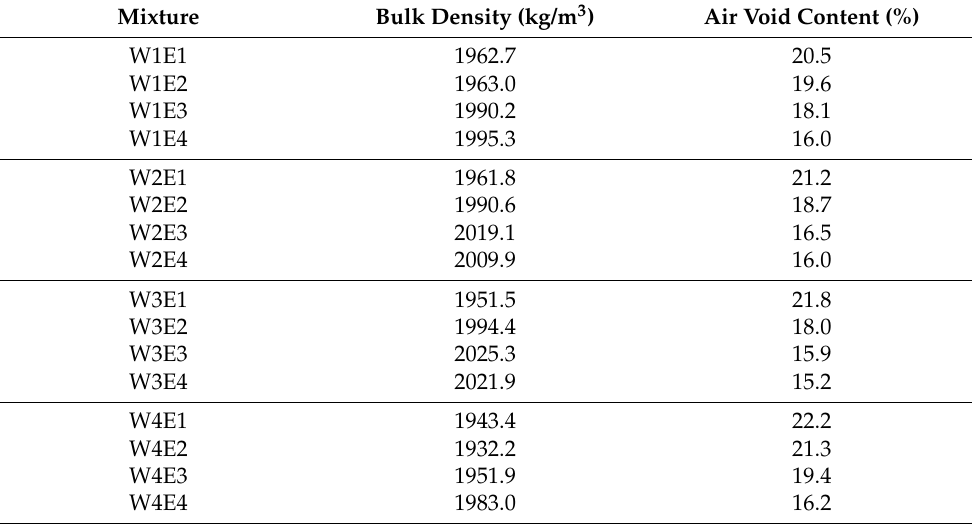
Table 5. Bulk density and air void content for mixtures by the gyratory compaction.